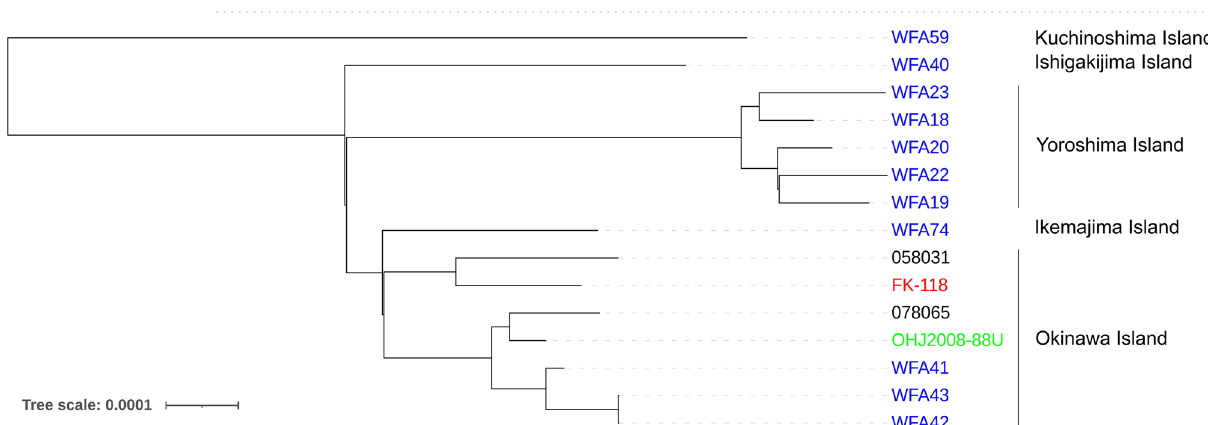
Figure 2. Core genome SNP-based maximum likelihood tree of L. borgpetersenii serogroup Javanica strains isolated in Japan. The strain Piyasena, belonging to serogroup Javanica serovar Ceylonica, was used as the reference, omitted from the tree. WGS of strains 058031, 078065, FK-118, and OHJ2008-88U was performed in this study, and strains named WFA have been analyzed in a previous study 30 . Black, human isolate; blue, black rat isolate; green, mongoose isolate; red, cat